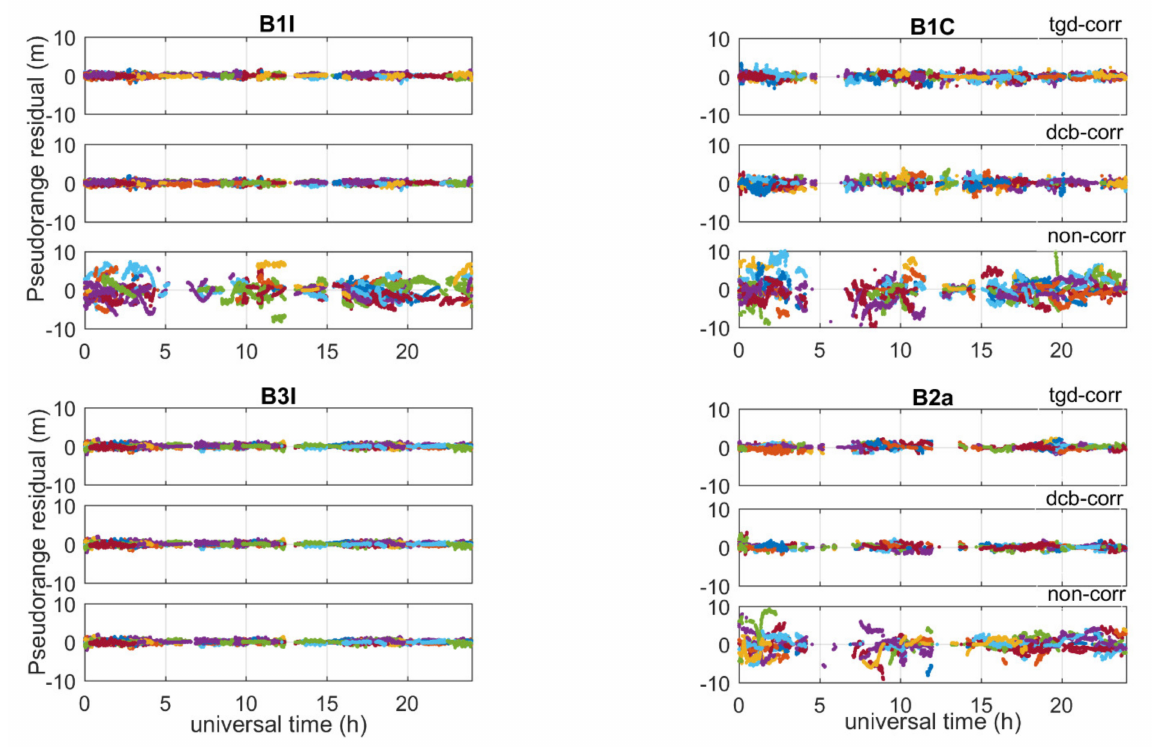
Figure 13. Pseudorange residual scatters of B1I, B3I, B1C and B2a SPP with different schemes at BRCH